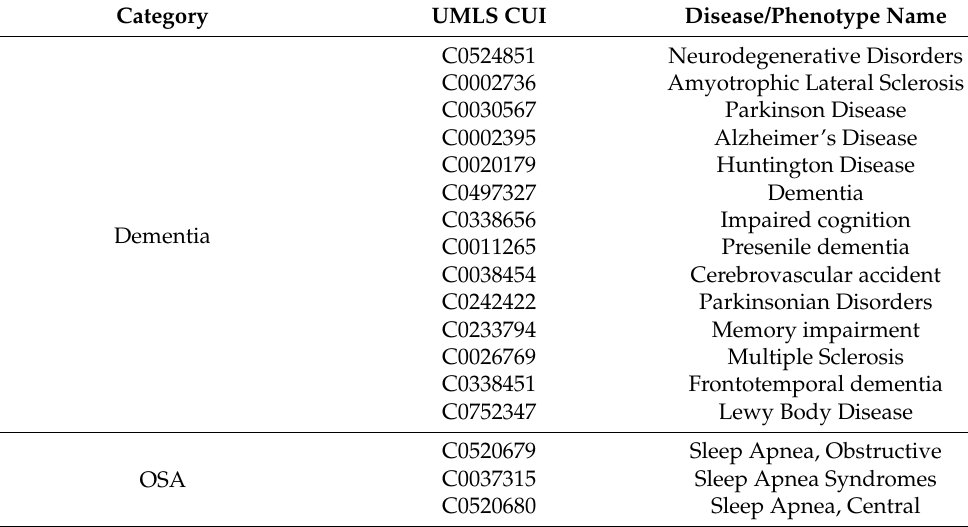
Table 1. The list of DisGeNET disease/phenotype identifiers (Unified Medical Language System Concept Unique Identifiers, UMLS CUI) used in the